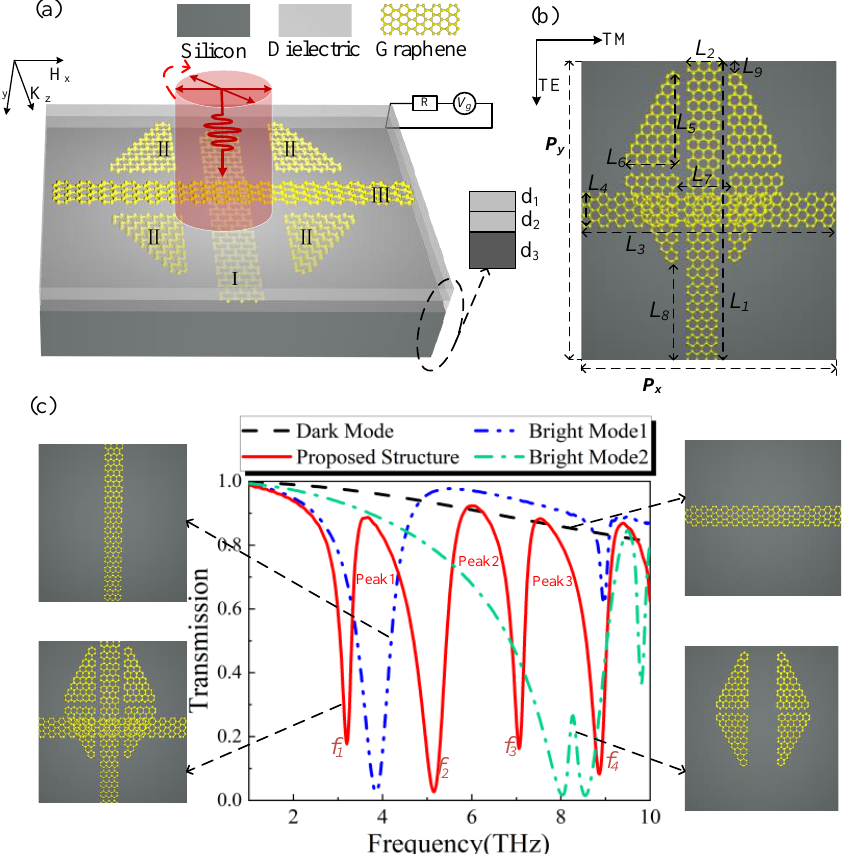
Figure 1. ( a ) Schematic diagram of the periodic 3D unit structure of the metamaterials. ( b ) A 2D top view of the unit structure. ( c ) Transmission spectra of different structures under y -polarized light irradiation when the Fermi levels being set to 1 eV.